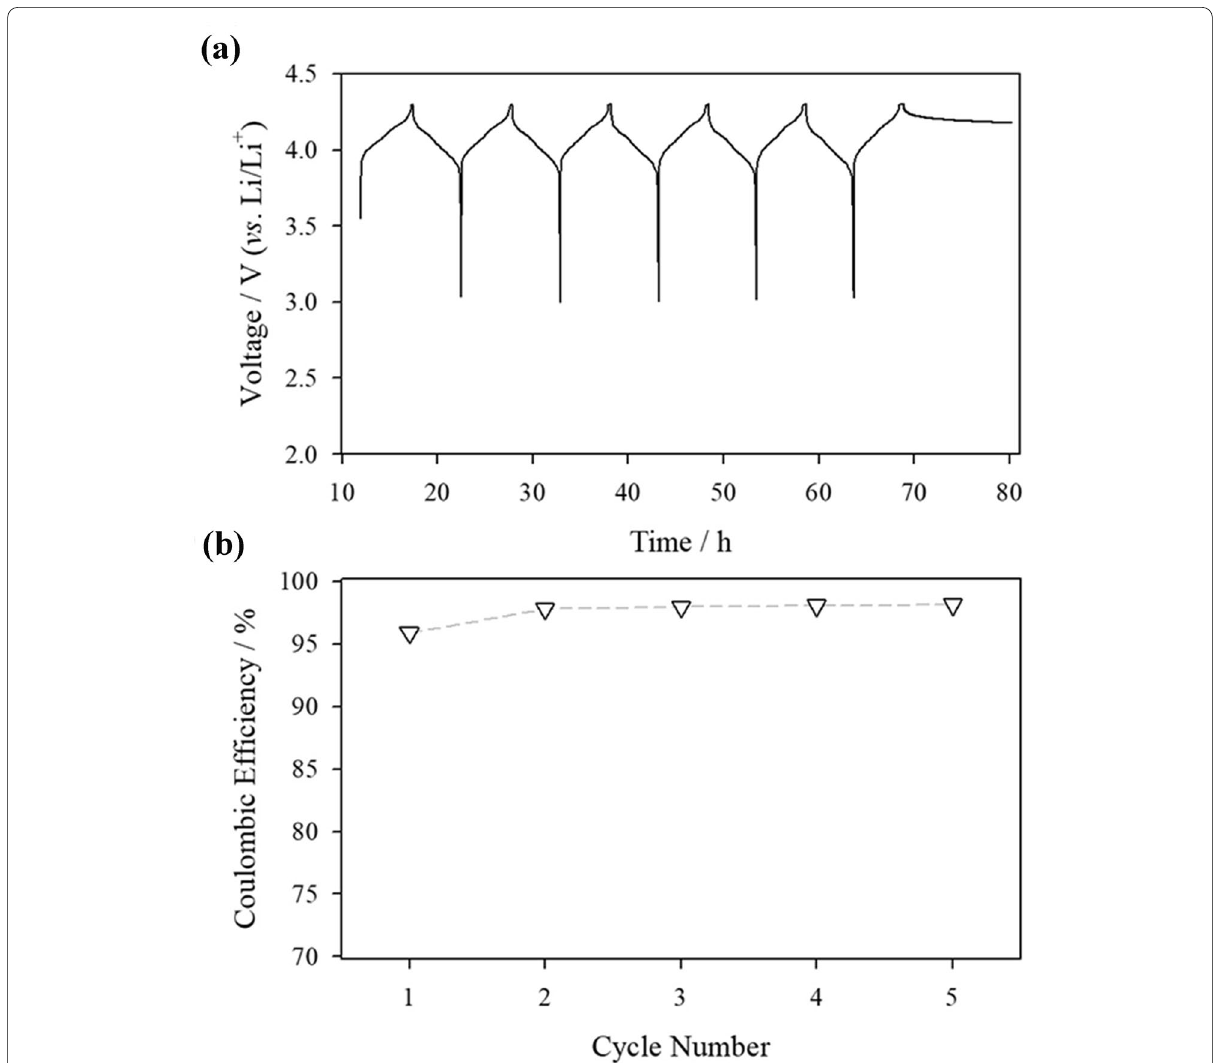
Fig. 2 a Chronopotentiogram from the 0.2 C galvanostatic charge–discharge at the voltage range of 3.0‑4.3 V ( vs . Li/Li + ) with Li/LMO cell and b Coulombic efficiency from the galvanostatic